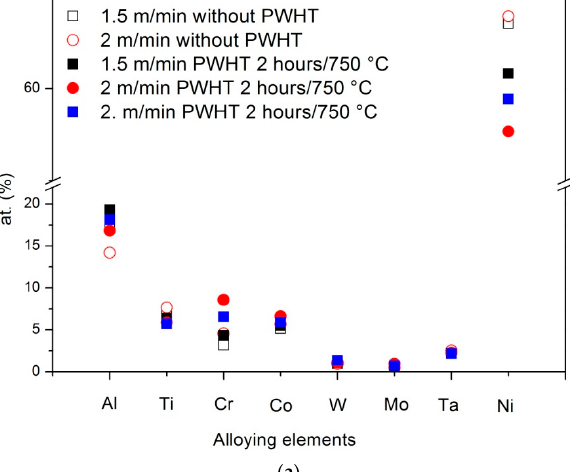
Figure 12. Electron back-scattering diffraction (EBSD) maps collected from joints realized with PHT = 300 °C and pass speeds v = 1.5 m/min ( a ) and v = 2.0 m/min ( b